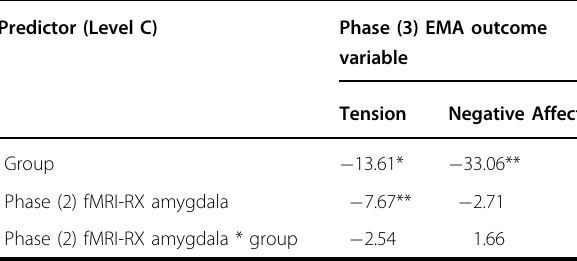
Table 4 Non-standardized β -values of the EMA HLM